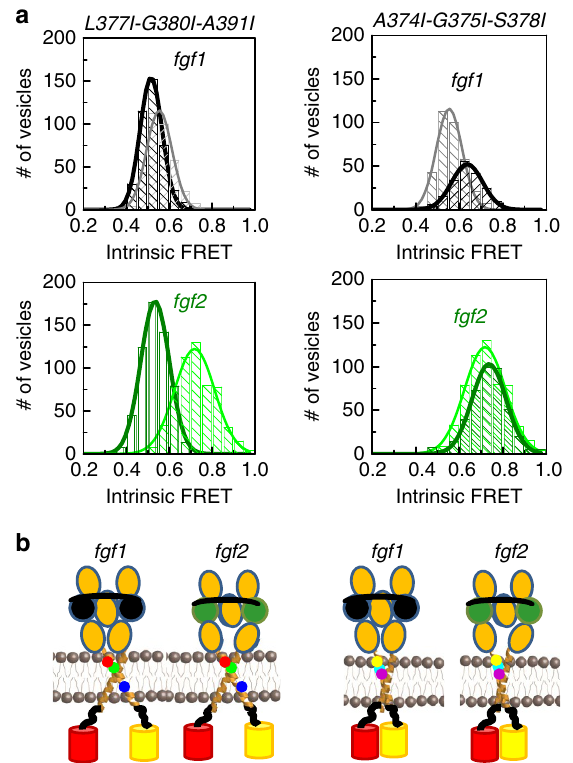
Figure 5 | Effect of the L377I-G380I-A391I and A374I-G375I-S378I mutations on the fgf1- and fgf2-bound FGFR3 dimer structures. Left: results for the L377I-G380I-A391I mutant. Right: results for the A374I-G375I-S378I mutant. ( a ) Intrinsic FRET values, measured for the truncated EC þ TM FGFR3 mutants. The histograms of measured intrinsic FRETvalues in single vesicles for the wild type are shown in grey for the fgf1 case and in green for the fgf2 case. The histograms for the mutants are shown in black in the presence of fgf1 and in olive in the presence of fgf2. The L377I-G380I-A391I set of mutations (left) decreases the intrinsic FRET in the presence of fgf2, down to fgf1 wild-type levels. The A374I-G375I-S378I set of mutations (right) increases the intrinsic FRET in the presence of fgf1. ( b ) Graphic representation of the findings that the L377I-G380I-A391I mutations abolish the fgf2-bound state and induce a transition to the fgf1-bound state, while the A374I-G375I-S378I mutations abolish the fgf1 state. Cartoons are not drawn to